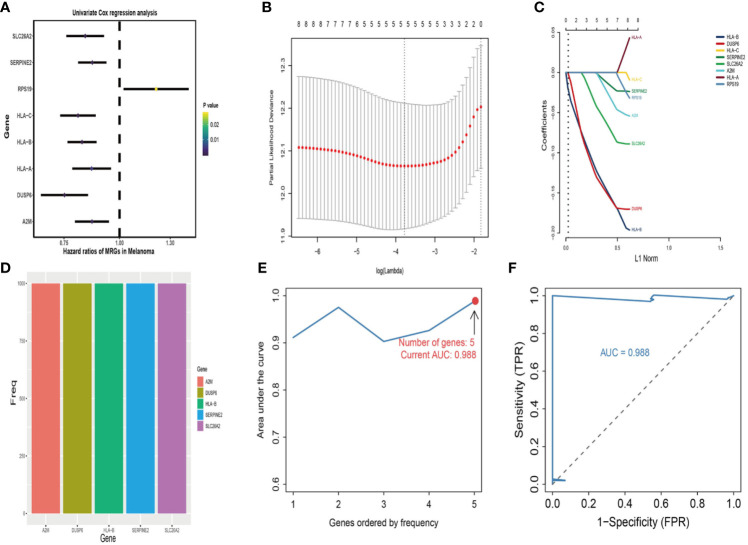
Identification of metastasis related genes (MRGs) biomarker for survival prediction. (A) Forest plots of 8 significantly survival-related MRGs. (B) Partial likelihood distribution with the corresponding λ-logarithm value and the left variants of model. (C) LASSO coefficient profiles of all survival-related MRGs. A vertical line is drawn at the value chosen by 10-fold cross-validation. (D) From 1000 iterations of lasso-penalized multivariate modeling, 5-MRGs were reported as optimal for survival prediction and achieved 1000 times; (E) The AUC curves of MRGs models in TCGA dataset, then the number of genes is five, the value of AUC reached the highest score (0.988). (F) The receiver operating characteristic (ROC) curves of 5-MRGs biomarker in 3 years.